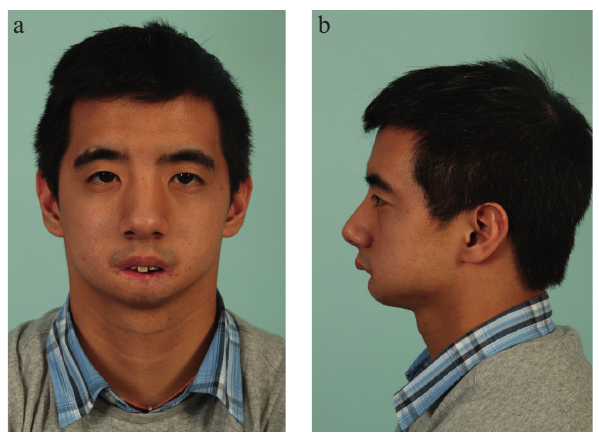
Fig. 1. a (left), b (right) : Contemplation of the face revealed a hypoplastic mandible with an inwardly lower lip and absent sulcus. The patient was unable to close his mouth properly. Oral examinations showed hypoglossia, ankyloglossia only 8 teeth of the upper and one molar of the lower jaw.